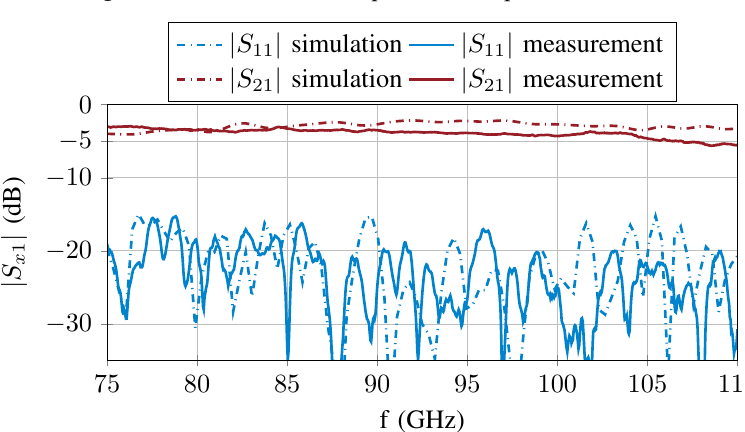
Figure 12. Measured and simulated S-parameters for orthogonal LC orientation of the SIF phase shifter.